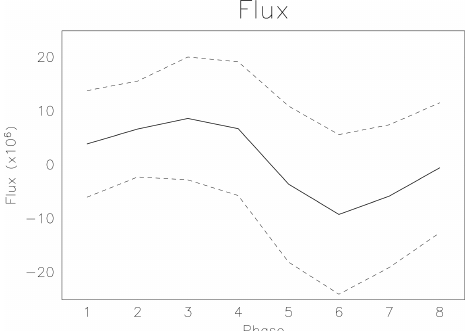
Figure 12. Mean value (solid line) and the range of standard devia- tion (broken lines) of the zonal flux of thickness-weighted low-PV air (kgK − 1 s − 1 ) at 60 ◦ E calculated at the 370K level for each of the eight phases.